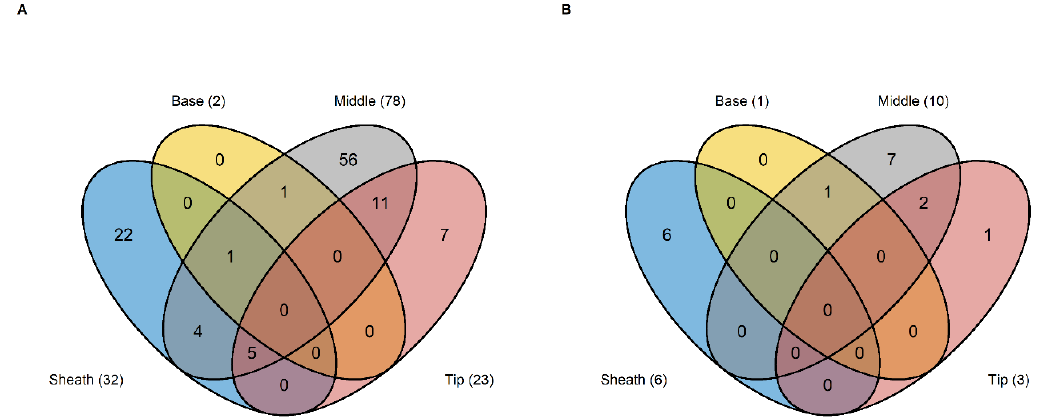
Figure 8. Venn plots representing overlapping significant differentially expressed genes for all leaf segments of the HNT-sensitive ( A ) and HNT-tolerant ( B ) cultivar group.